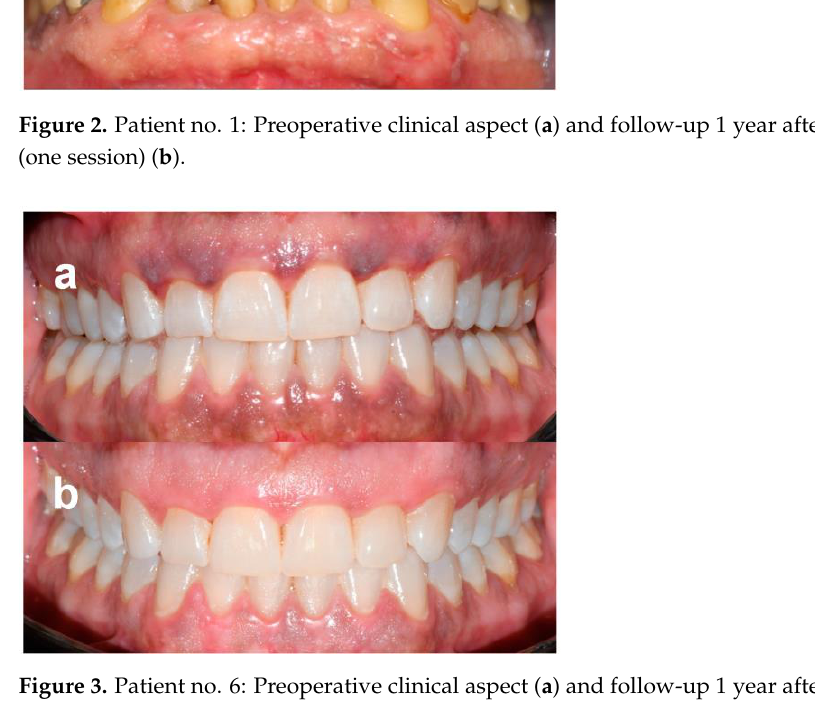
Figure 3. Patient no. 6: Preoperative clinical aspect ( a ) and follow-up 1 year after laser application (two sessions) ( b ).